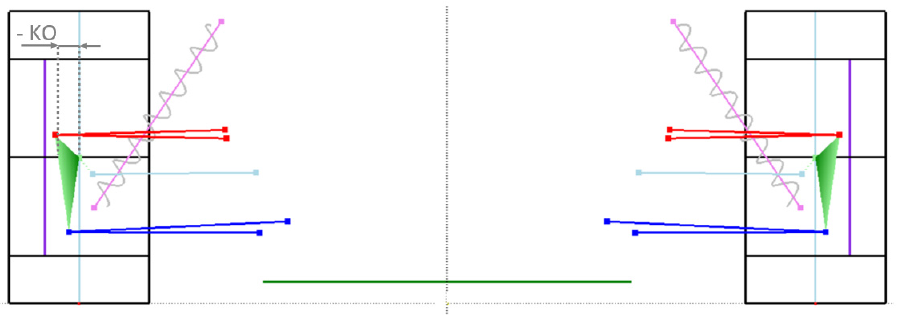
Figure 19. Schematic front view (yz plane) of the EB3 suspension, with large and negative KO.